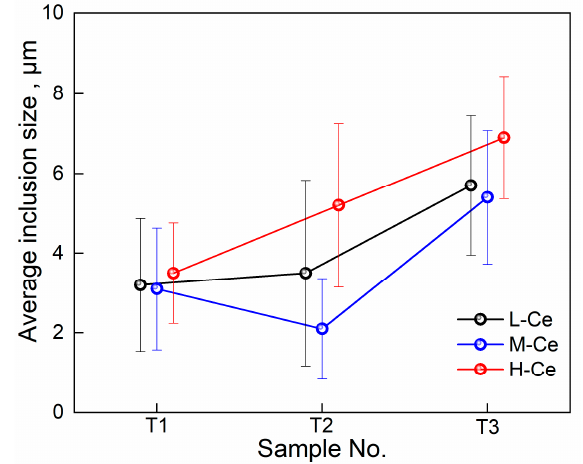
Figure 7. Statistical results for inclusion size.